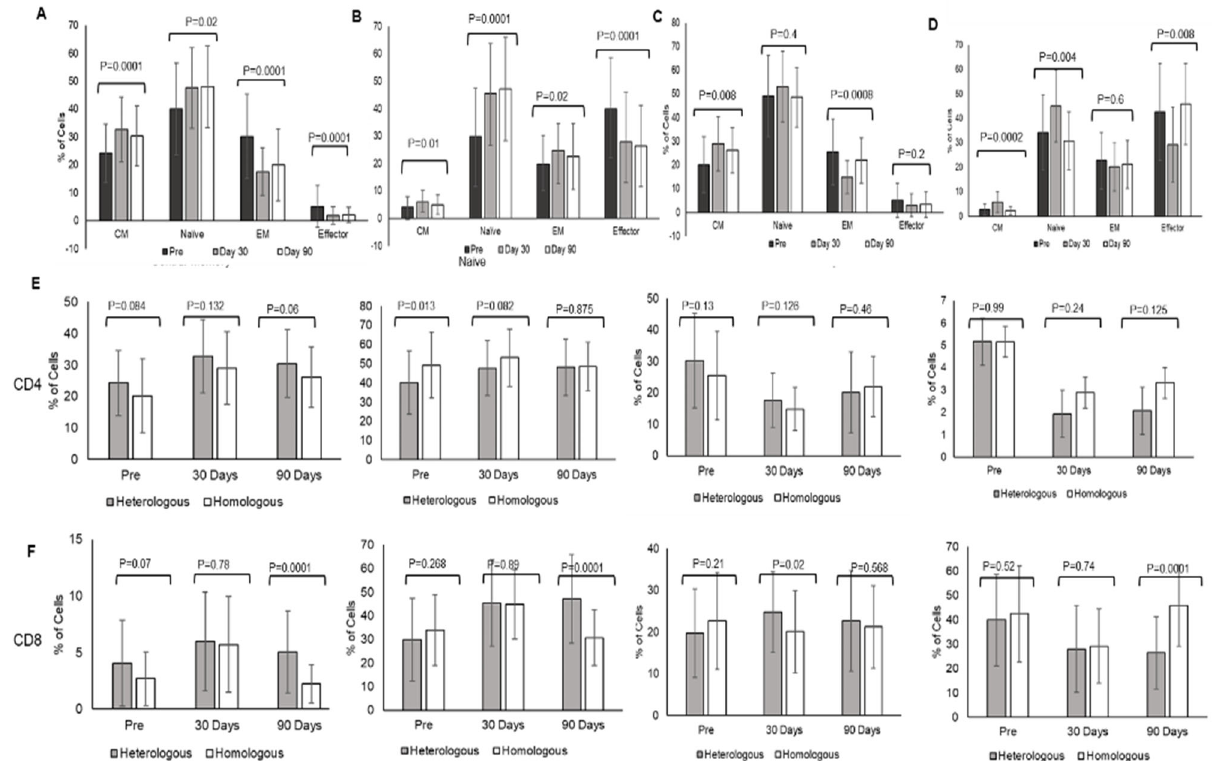
Figure 2. Immunological memory: Corbevax vs. Covishield in T lymphocytes: T memory immune response analysis of ( A ) CD4 and ( B ) CD8 in heterologous booster, ( C ) CD4 ( D ) CD8 in homologous booster employing flow cytometry for central memory (CM) CCR+CD45RA − , Naïve CCR7+CD45RA+, effector memory (EM) CCR7 − CD45RA − effector (Eff) CCR7 − CD45RA+ popula- tions and p values were shown together for pre, day 30, and day 90. Differential immune memory responses comparison of heterologous and homologous booster doses together in ( E ) CD4 and ( F ) CD8 T lymphocytes and p values were compared in between the groups.